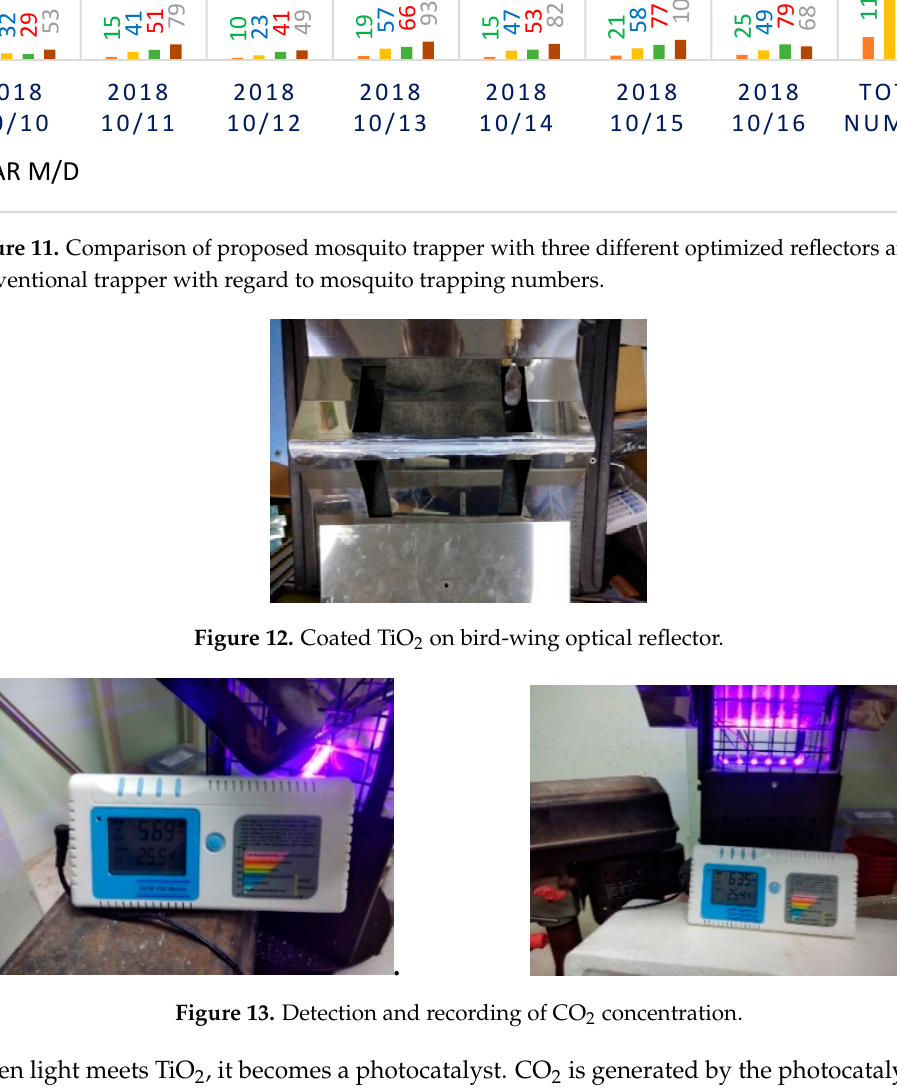
Figure 11. Comparison of proposed mosquito trapper with three different optimized reflectors and the conventional trapper with regard to mosquito trapping numbers.